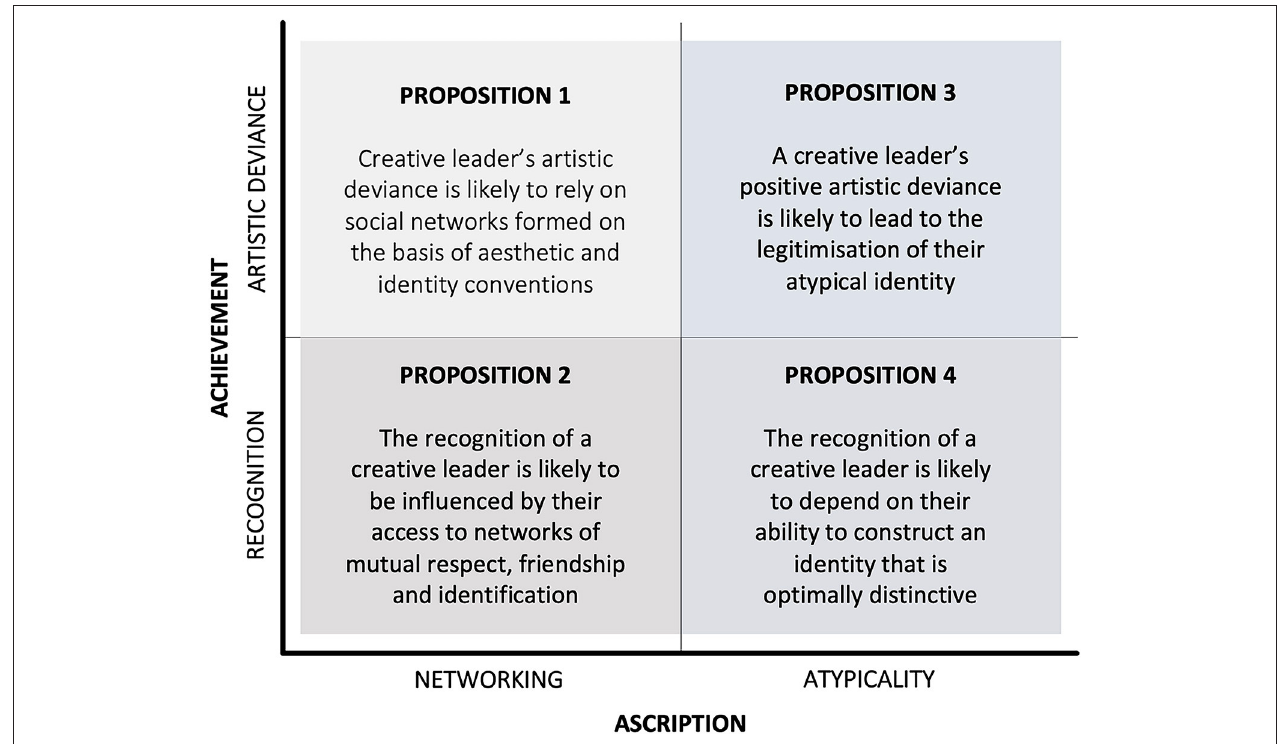
FIGURE 1 | Propositions about achievement and ascription processes of creative leader emergence. Source: The authors.